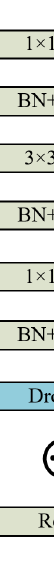
Figure 2. Improved residual block.